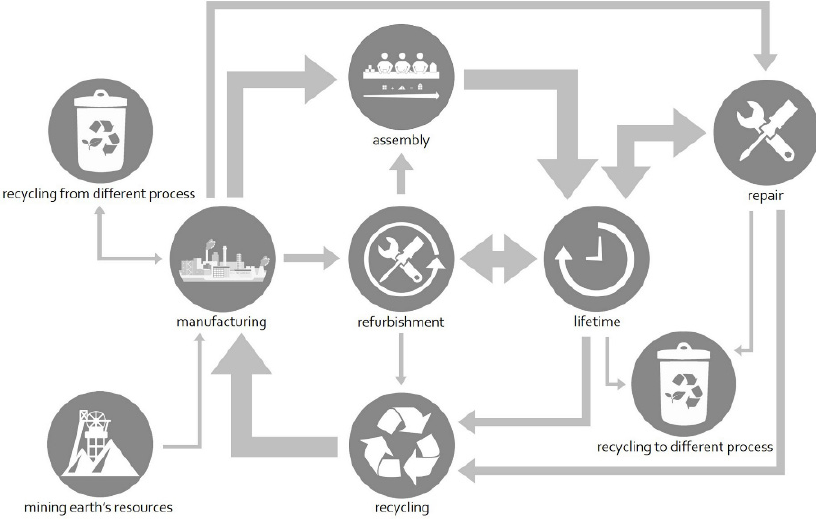
Figure 3. Illustration of material flowchart in the circular economy [25].